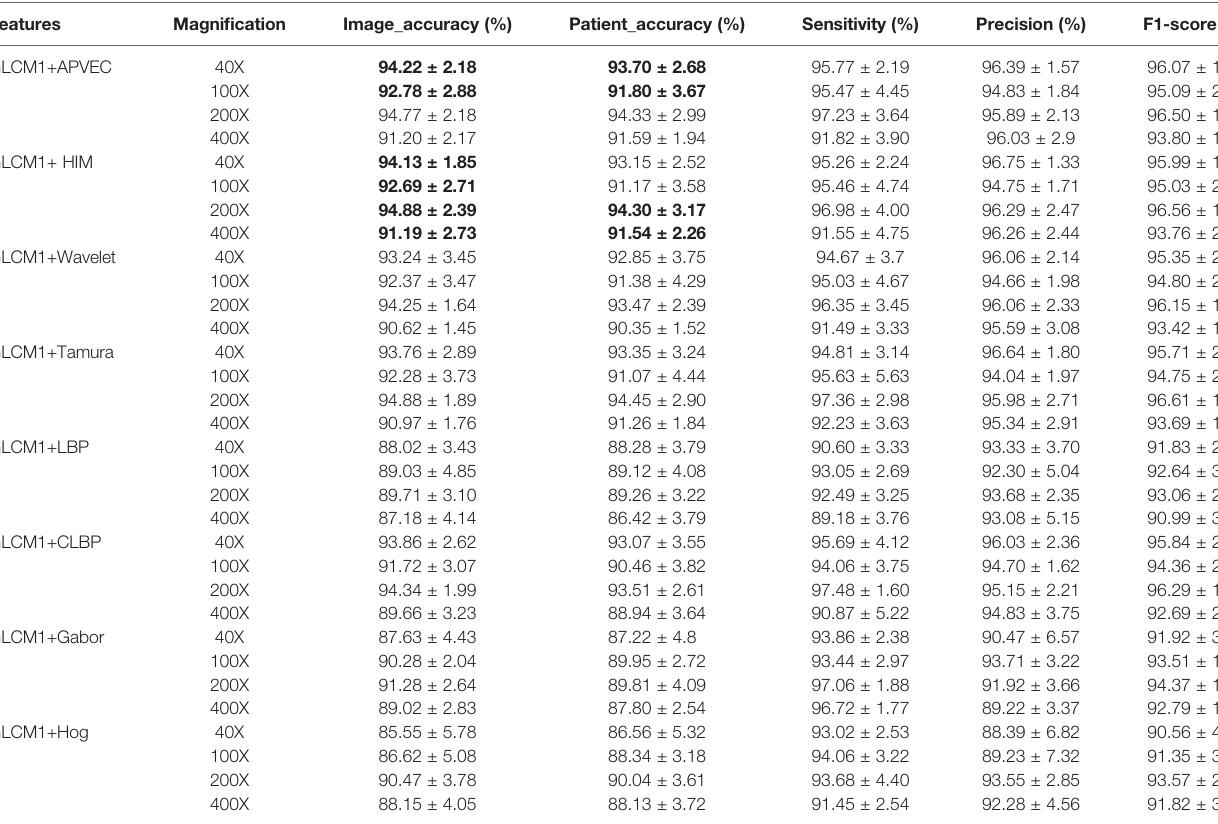
The bold values indicate that the recognition accuracy of combining the two features is better than that of a single